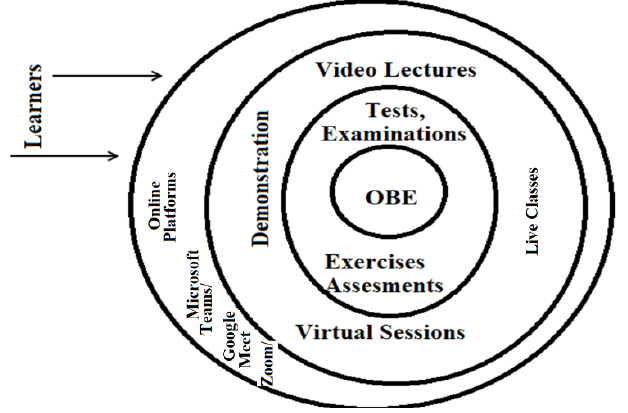
Figure 9. Layered architecture to achieve OBE